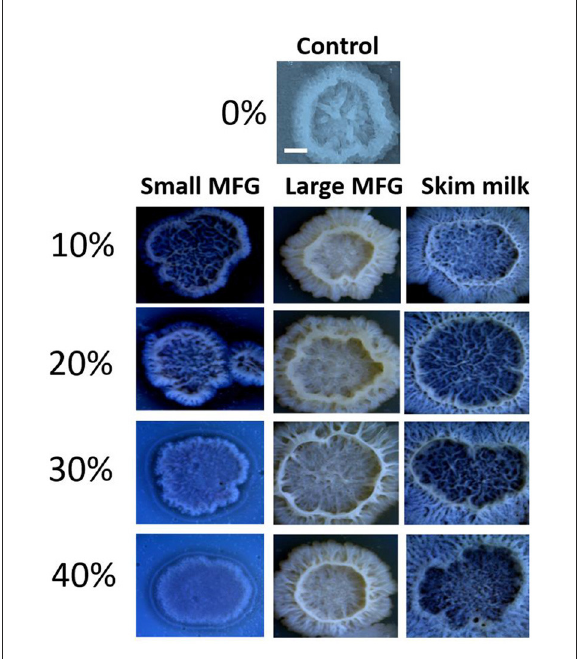
FIGURE5 Size of MFG incorporated into a solid substrate affects the structure of biofilm colonies formed by B. subtilis . LBGM plate with no milk fraction was used as a control. Scale bar represent 3mm. Different concentrations (v/v) of small or large MFG were incorporated into agar to form a solid substrate to study colony-type biofilm